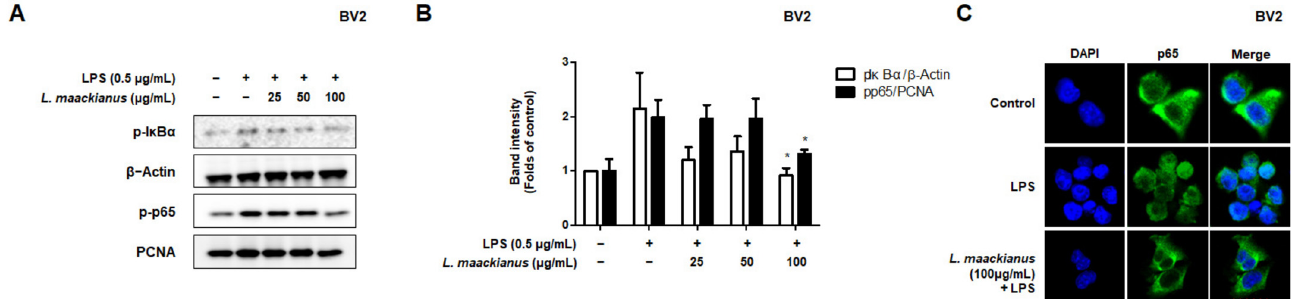
Figure 4. Effects of Lycopus maackianus extract on nuclear factor-kappa B (NF- κ B) p65 activation in BV2 cells. ( A ) Western blotting was performed after treating the cells with L. maackianus MeOH extract at the indicated concentrations for 3 h, followed by stimulation with lipopolysaccharide (LPS; 0.5 µ g/mL) for 0.5 h. ( B ) The immunoblot was quantified using the ImageJ software. Band intensities were normalized to those of β -actin. ( C ) NF- κ B (p65) localization in BV2 cells were visualized and photographed using a Zeiss fluorescence microscope. Data are the average of three independent experiments. Untreated control groups were included. * p < 0.05 compared with LPS-treated group.